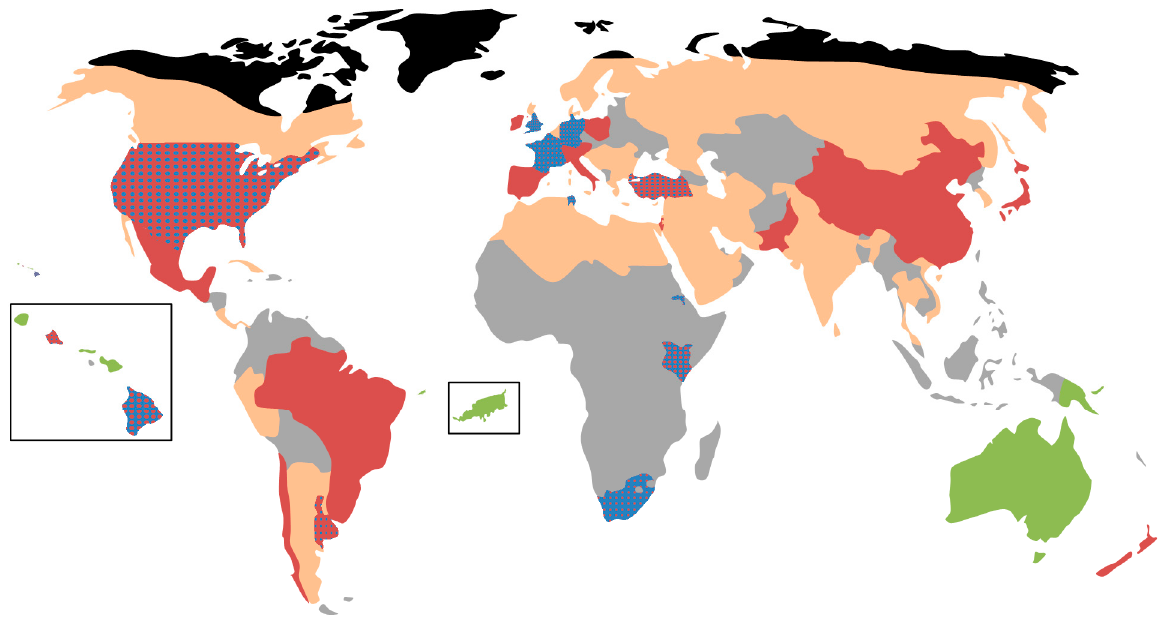
Figure 2. Global distribution of DWV in Apis mellifera. Red = DWV-A, blue = DWV-B, orange = DWV present but dominant strain unknown, grey = no data available, green = DWV absent or present at very low genome equivalents, Black = Apis mellifera absent. Blue dots on a red background indicate that DWV-A is dominant, but DWV-B is present conversely red dots on a blue background indicate that DWV-B is dominant, but DWV-A is present. The map was constructed by combining global level DWV data [33,34] with more detailed country level info as follows: Argentina (Buenos Aires and Sante Fe) [35], Australia [36], Brazil [37], Chile [38], China [39], Cuba [40], Ethiopia (Tigray) [41], Fernando de Noronha [25], France [20], Germany [32], Hawaii [This study, 26], Kenya [42], Papua new guinea [13], South Africa [30], Tunisia [43], Turkey [44], UK [16], Uruguay [45], USA [16]. The studies used to create this diagram were not required to have used the same primer set as our study.